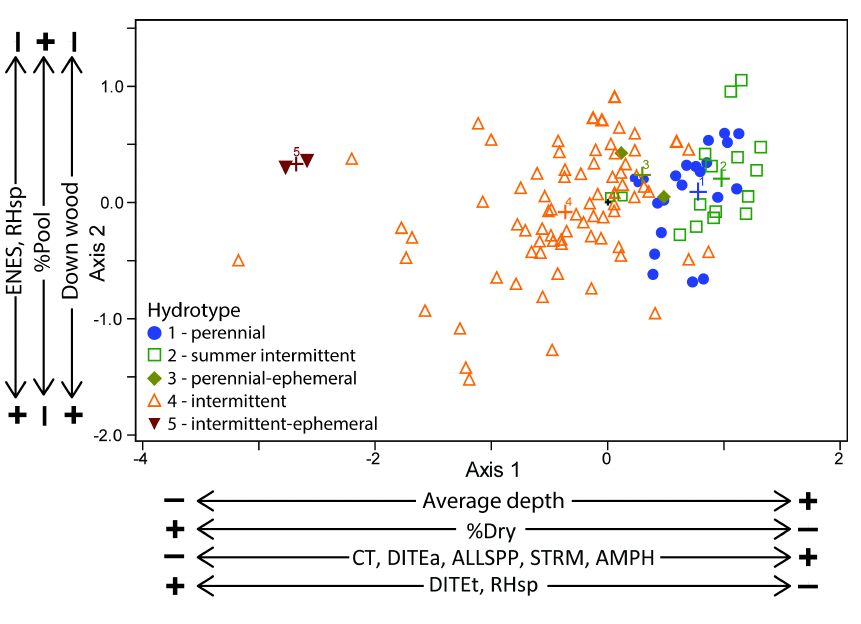
Figure 2. Non-metric multi-dimensional scaling ordination of 59 stream reaches described by 24 habitat characteristics; arrows show habitat and animal density patterns with axes, in positive and negative directions of abundance; species acronyms: CT, cutthroat trout, Oncorhynchus clarkii ; DITEa, aquatic Dicamptodon tenebrosus , found in streams; DITEt, terrestrial D. tenebrosus , found on stream banks; ALLSP, all species; STRM, all instream species; AMPH, all amphibians; RHsp., Rhyacotriton spp.; ENES, Ensatina eschscholtzii .